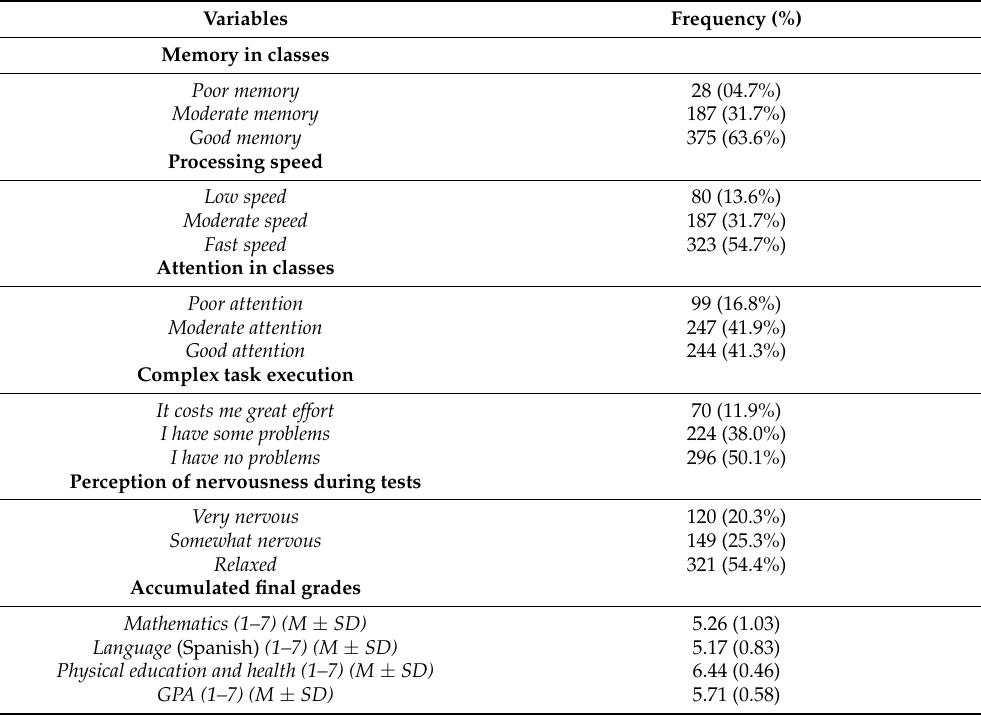
Table 2. Perception of cognitive functions in educational